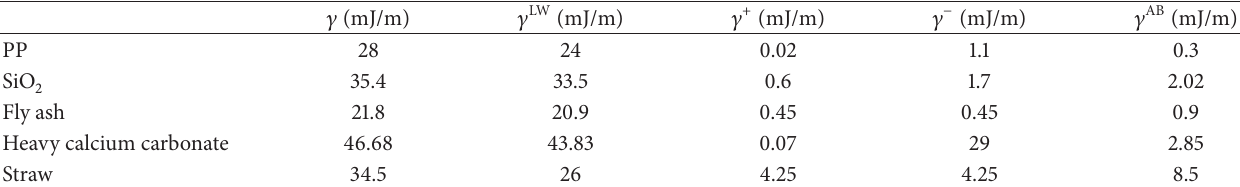
Table 1: Surface energy parameters of PP and fillers.